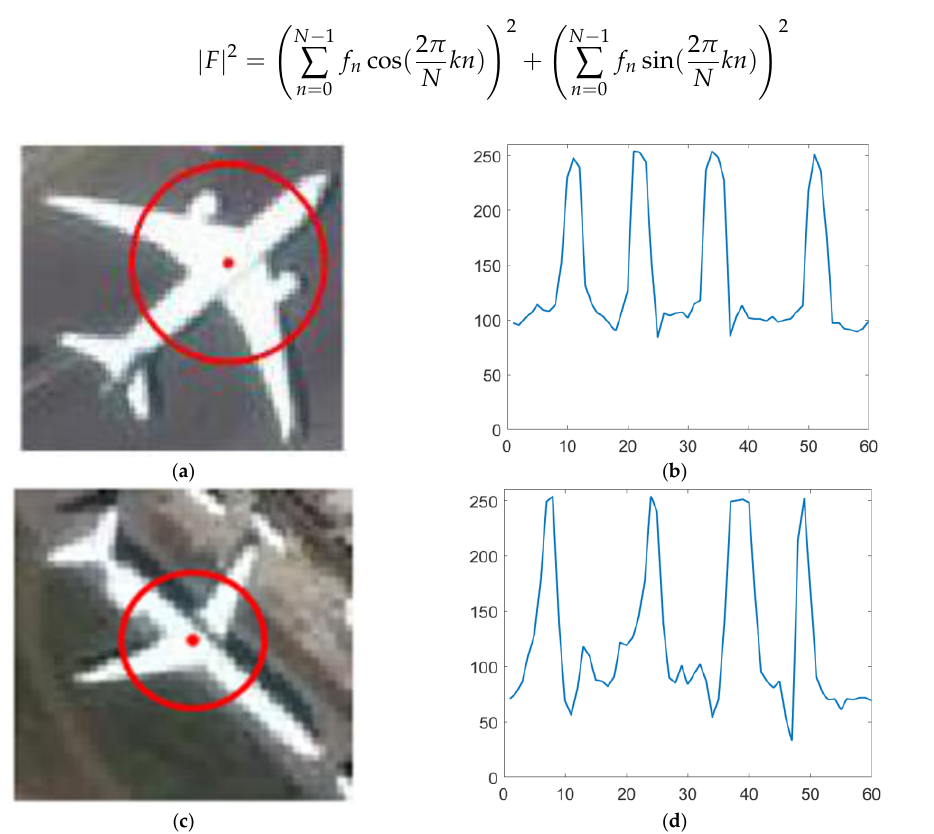
Figure 3. The aircraft and corresponding circular intensity signal waveform charts. ( a , c ) Aircraft in RSIs; ( b , d ) circular intensity signal waveform charts centered at aircraft’s central point.